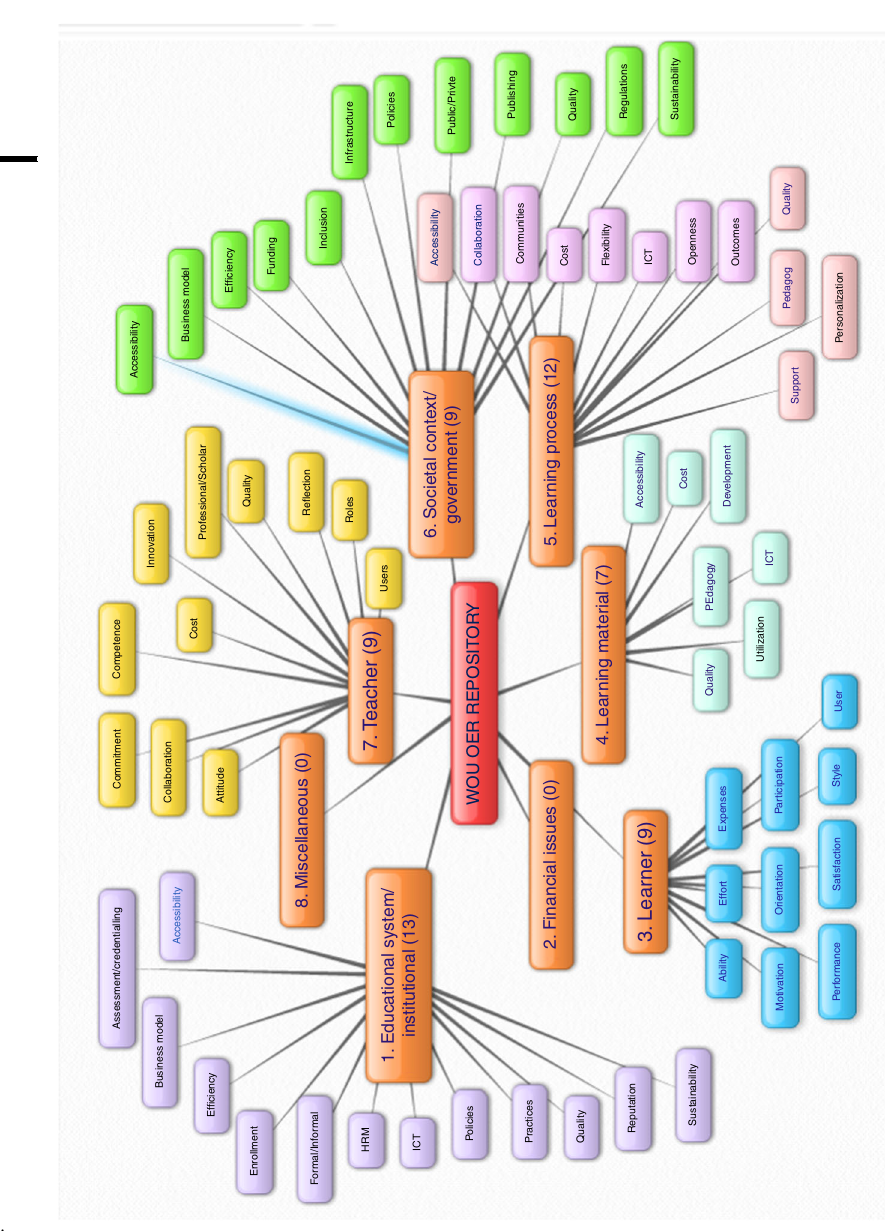
Figure 3. WOU OER repository collections mapping by